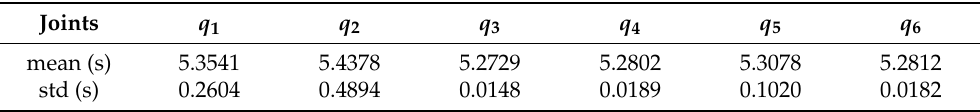
Table 2. The time information of the 25-run simulation of the proposed method for full-speed signals with 5